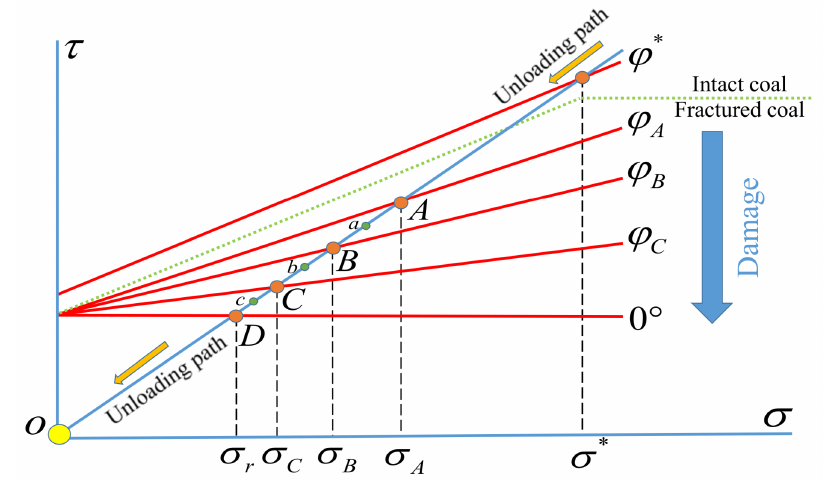
Figure 16. Strength evolution of fractured